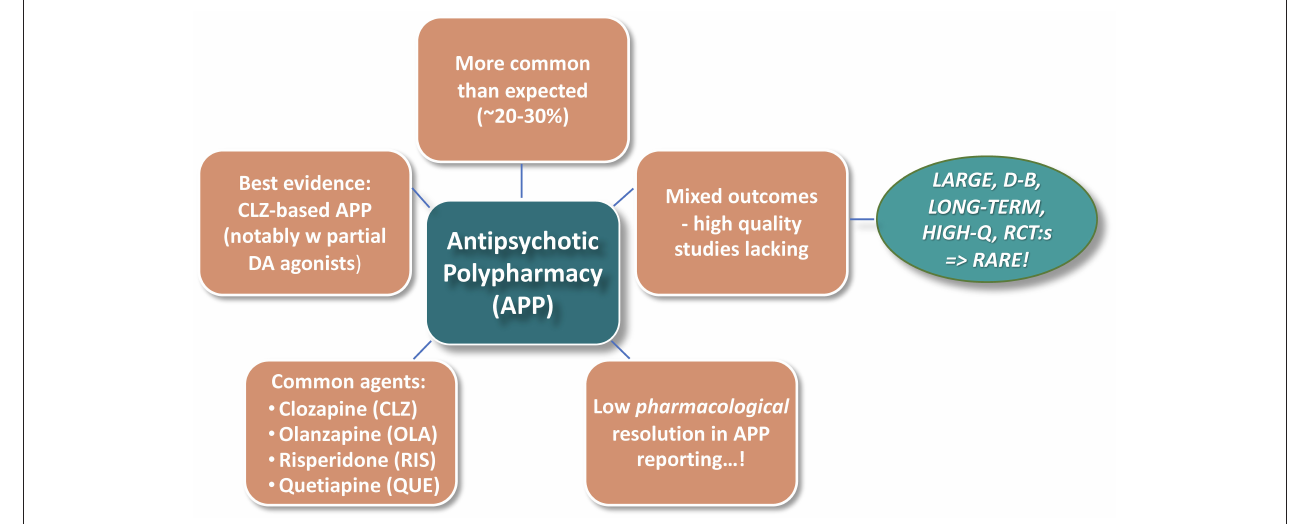
FIGURE 1 | Antipsychotic polypharmacy (APP)—broad literature background